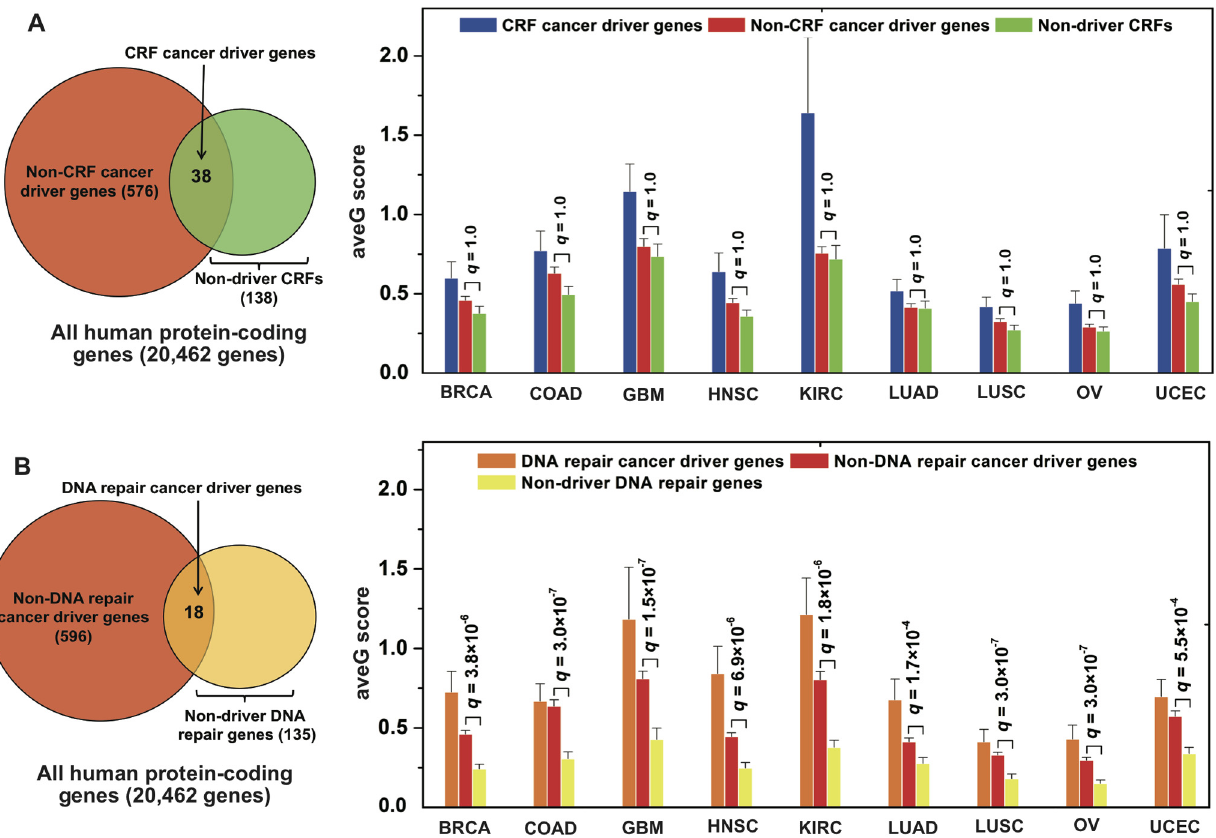
Fig 3. Combined effects of genetic and epigenetic alterations. The left Venn diagrams show the relationship between cancer driver genes and ( A ) chromatin regulation factors (CRFs) and ( B ) DNA repair genes. The right panels show the distributions of the average gravitation (ave G ) score of three gene sets in the corresponding left Venn diagram across 9 cancer types: ( A ) comparison of CRF cancer driver genes, non-CRF cancer driver genes, and non- driver CRF genes; ( B ) comparison of DNA repair cancer driver genes, non-DNA repair cancer driver genes, and non-driver DNA repair genes. The adjusted p-values ( q ) are calculated by the Wilcoxon rank-sum test and corrected by Benjamini-Hochberg multiple testing. The detailed data is provided in S5 and S7 and S8 Tables.